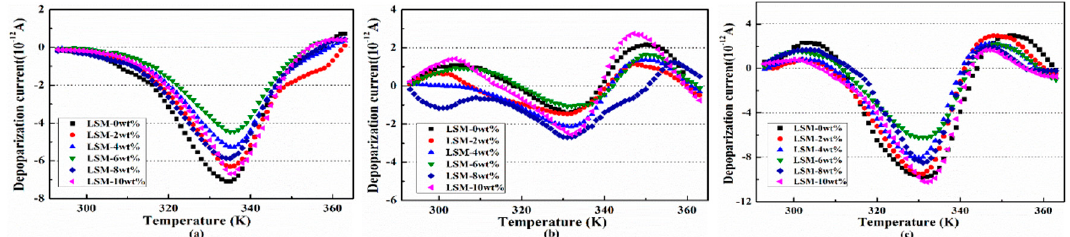
Figure 10. Depolarization current in insulation under semi-conductive composites with different La 0.8 S r0.2 MnO 3 contents. ( a ) 10 kV/mm; ( b ) 20 kV/mm; ( c ) 30 kV/mm.